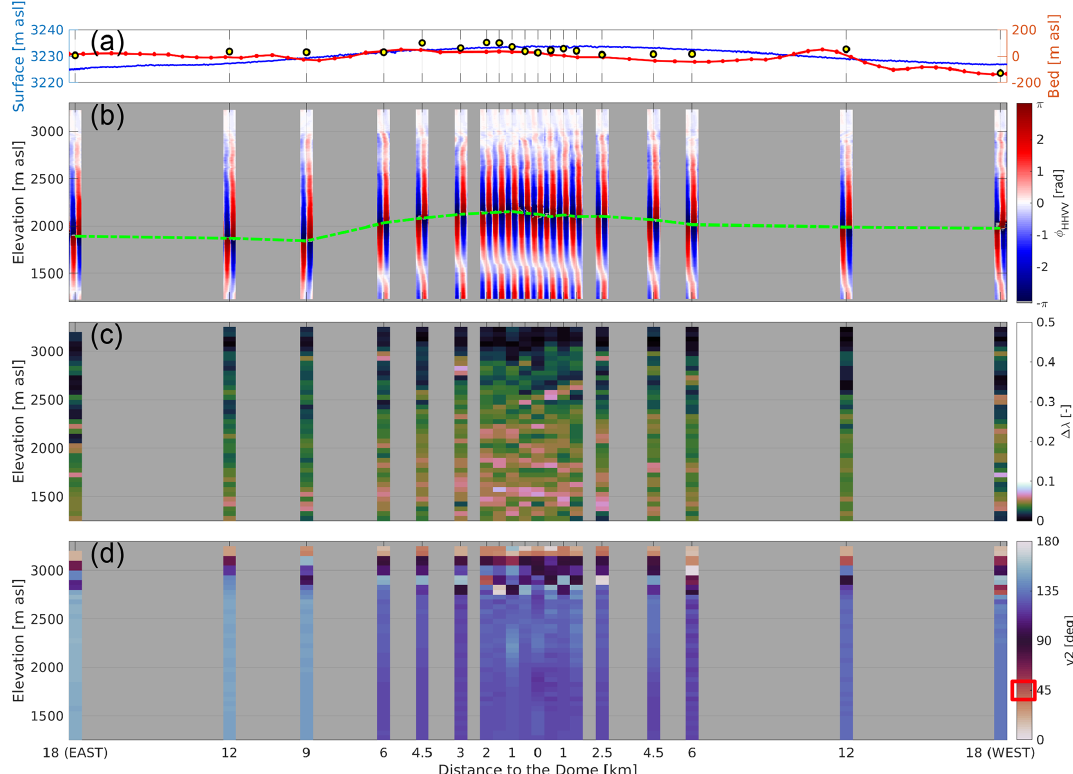
Figure 7. Ice fabric evolution in the local dome-to-flank transition at Dome C. (a) Surface (Howat et al., 2019) and bed (Morlighem et al., 2020) elevation in meters above sea level. Yellow circles are the measured bed elevation from radar power return at each site. (b) Observed polarimetric coherence phase difference ( φ HHVV ) at each site. The dashed green line connects the nodes at each site. (c) The optimized horizontal anisotropy ( (cid:49)λ ). (d) The optimized orientation of the largest horizontal eigenvector ( v 2 ). The red rectangle in the legend marks the surface flow direction. All panels are corrected for the surface elevation, i.e., statically corrected.